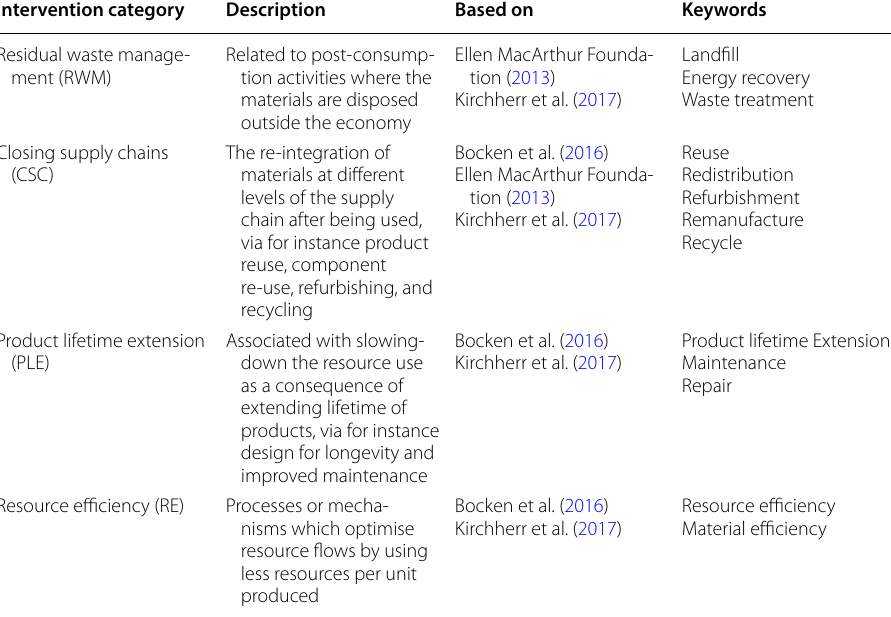
Table 1 Circularity intervention categories Intervention